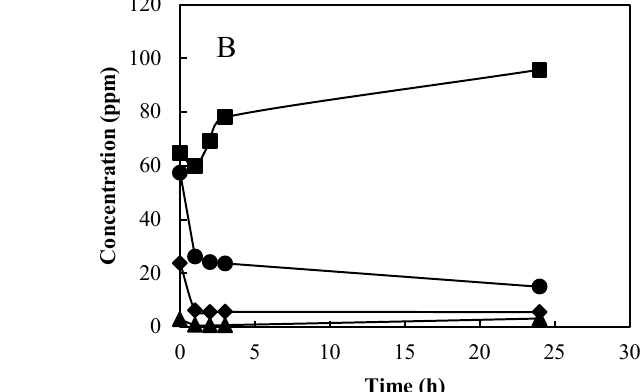
Figure 6. Kinetics of grapefruit juice debittering catalyzed by free enzyme: ⯁ Limonin; ● Naringin; ∎ Prunin; ⯅ Naringenin . Figure 8. Kinetics of grapefruit juice debittering using enzyme immobilized in ( A ) BGA and ( B ) OGA. ⯁ Limonin; ● Naringin; ∎ Prunin; ⯅ Naringenin. Before applying immobilized biocatalysts, the adsorption capacity of the supports was evaluated (Figure 7). Both enzyme ‐ free supports allowed for the adsorption of all bitter compounds; however, the best performance was observed with BGA, which